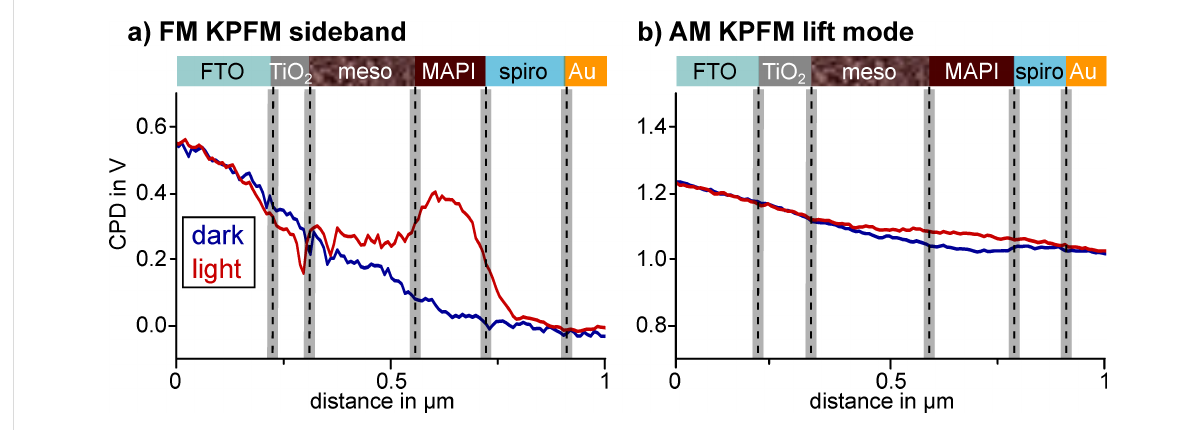
Figure 1: CPD line profiles of two KPFM experiments on the same cross section of a mesoscopic perovskite solar cell under short circuit conditions with and without illumination, visualized by the red and blue line, respectively. The cell consisted of a fluorine-doped tin oxide (FTO) electrode, a compact TiO 2 electron extraction layer and a mesoscopic TiO 2 layer (meso) filled with the perovskite light-absorber methylammonium lead iodide (MAPI). The mesoscopic layer was followed by a compact MAPI capping layer, the hole transport material spiro-OMETAD and a gold electrode. Prior to the measurement the cross section of the solar cell was polished with a focused ion beam (FIB) to minimize topographic crosstalk. The CPD line profiles in a) were extracted from double side band frequency modulation KPFM (FM sideband) scans in single pass with VAC of 3 V [7]. The CPD line profiles in b) were extracted from amplitude modulation KPFM (AM lift mode) scans in lift mode with a tip–sample distance of 10 nm, an oscilla- tion amplitude of ≈ 80 nm and a tip voltage U AC of 1 V. Each line profile is an average of three adjacent scan